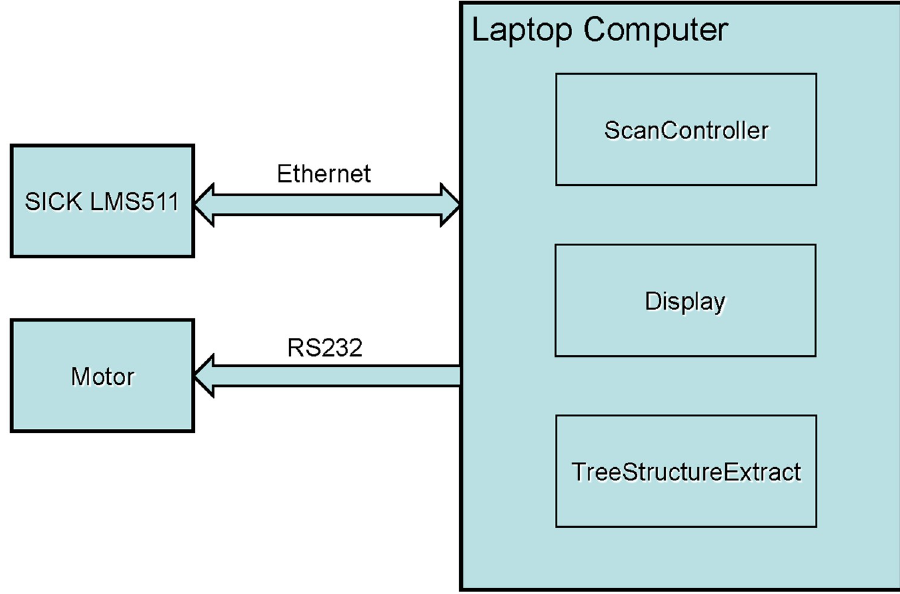
Fig 1. The scheme map of the BEE